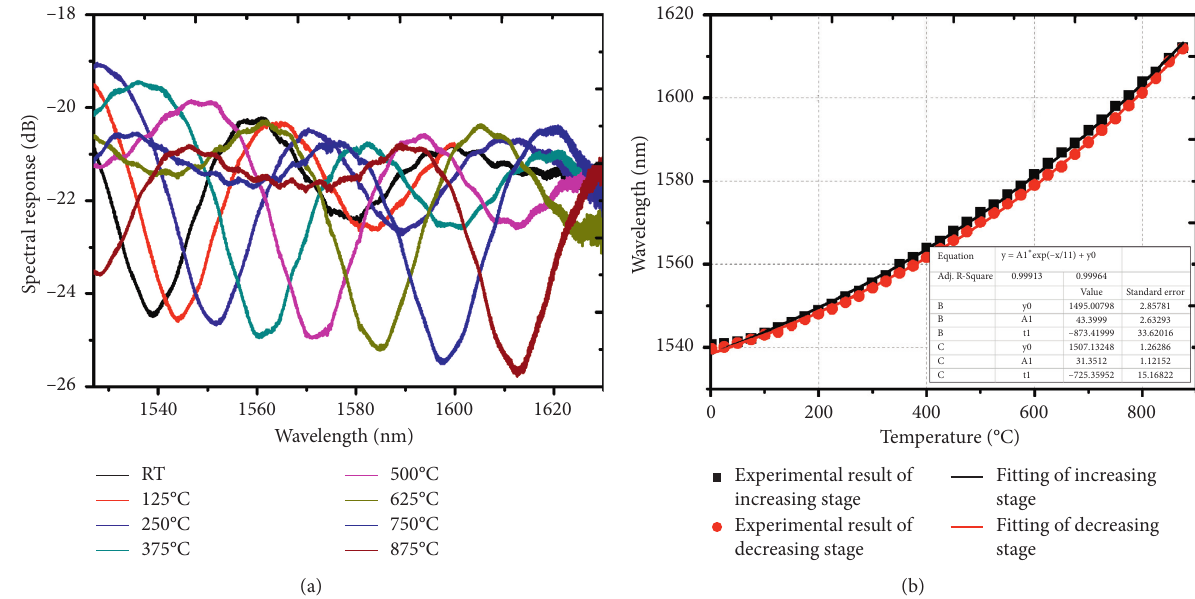
Figure 4: (a) Measured spectral responses at different temperatures ranging from RM to 875 ° C with intervals of 125 ° C; (b) the relationship between corresponding dip wavelength shifts and the temperature.